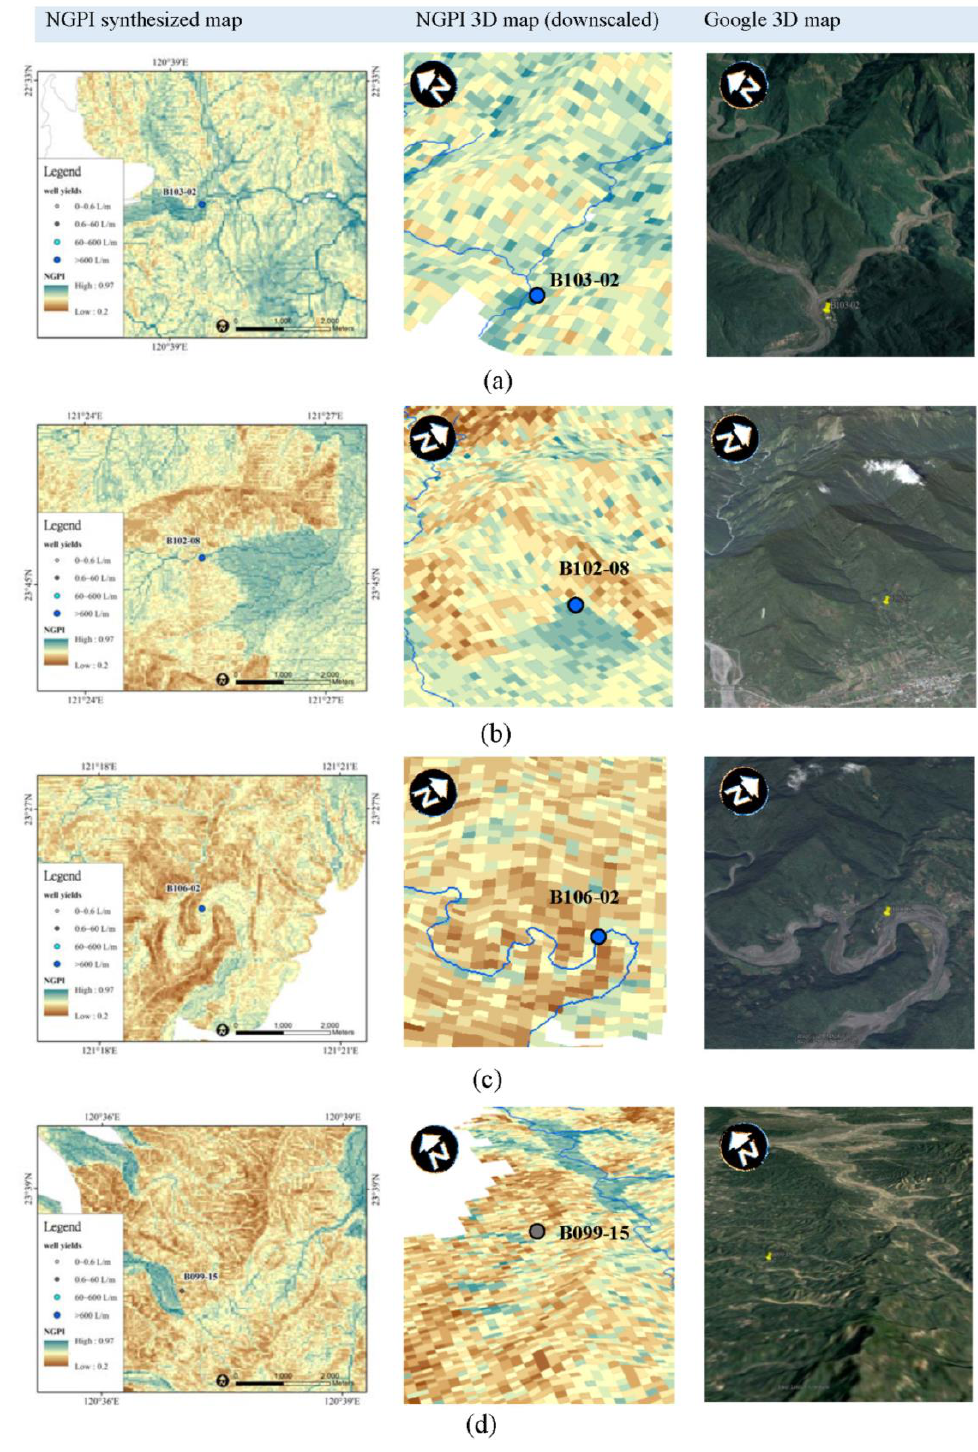
Figure 14. Three-dimensional (3D) visualization of NGPI map and satellite imagery at investigated sites (Figure 13). Without comparing the 3D visualization of the NGPI maps with a Google map, it is difficult to link the results of GWPS with these descriptions of groundwater potential from the ancient proverbs: ( a ) more groundwater at confluences of two rivers (at B103-02 GWPS); ( b ) more groundwater at intersection of two mountains (at B102-08 GWPS); ( c ) more groundwater at concave side of riverbed and foot of mountain (at B106-02 GWPS); ( d ) less groundwater at nearly horizontal bedding of rocks (at B099-15